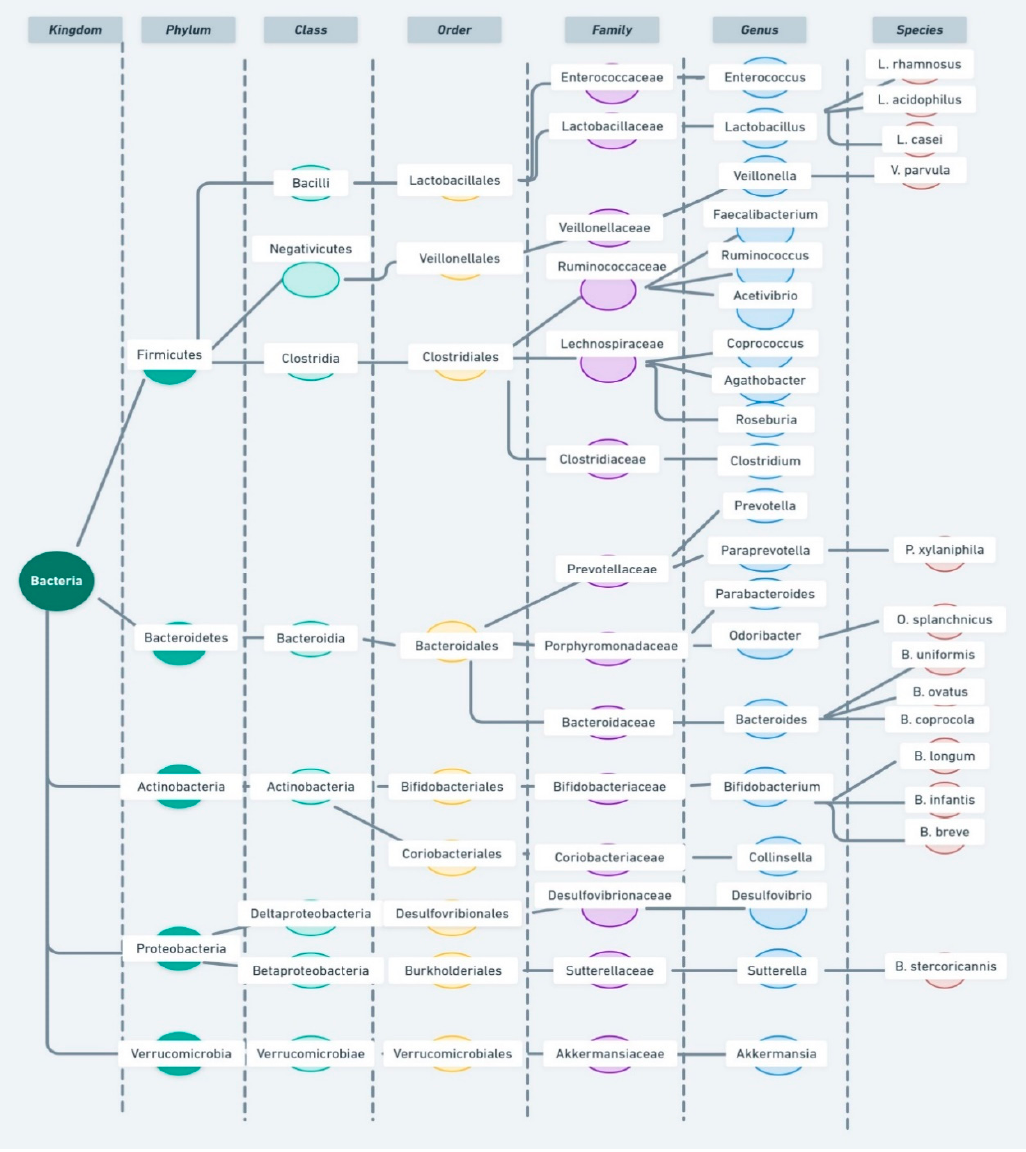
Figure 2. Bacterial taxonomic classification including the genera cited in this article according to the National Center for Biotechnology Information (NCBI) Taxonomy Database [161,162] .